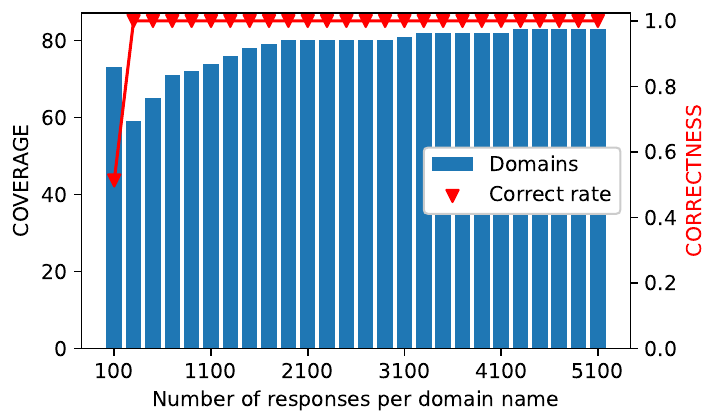
Figure 22. CORRECTNESS and COVERAGE of the valid IP’s identification